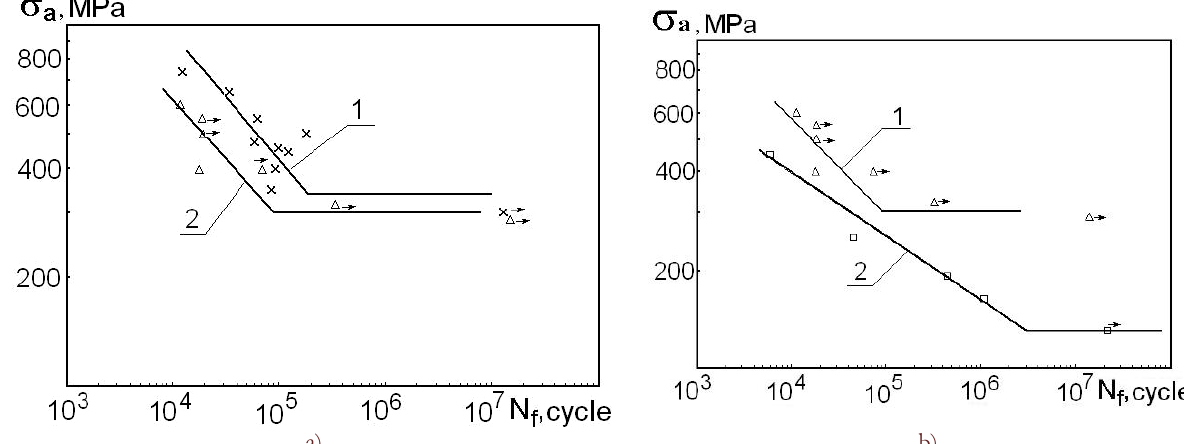
Figure 2: Mono S-N curves for tested smooth specimens: (a) symmetrical case for (1) not tempered and (2) tempered specimens; (b) at R>0 for (1) TP- specimens and (2) T-specimens.